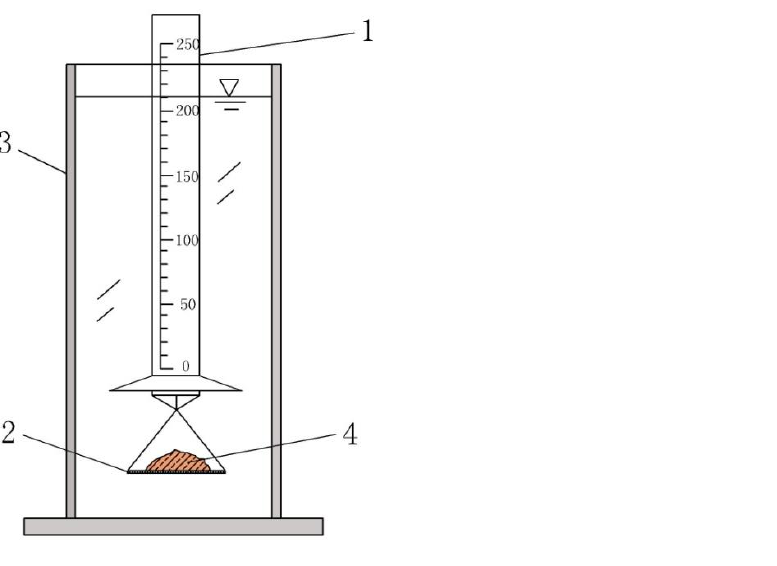
Figure 3. Schematic of disintegration tests. 1. Floating cylinder: graduated cylinder with a measuring range of 250 mL and minimum scale of 2 mL; 2. metallic meshy plate: the size is 10 cm × 10 cm; the grid aperture is 1 cm × 1 cm; it is connected to the floating cylinder with a thin thread; 3. glass flume: the size is 25 cm (width) × 25 cm (length) × 80 cm (height), and it is filled with pure water; 4. soil sample.